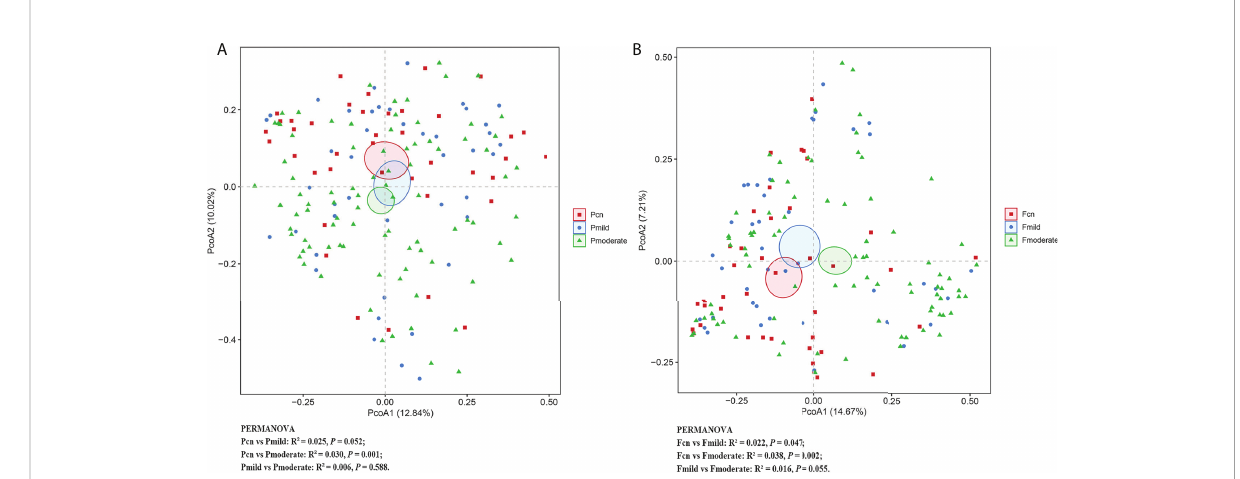
FIGURE 2 The b -diversity analysis of the subgingival plaque (A) and fecal (B) microbiota among the three groups. PCoA based on the Bray-Curtis of b -diversity analysis. PERMANOVA tests if the centroids, similar to means, of each group are signi fi cantly different from each other. R² statistic showing the community variation between the compared groups with signi fi cant p -values. Pcn, subgingival plaque of normal cognition controls; Fcn, feces of normal cognition controls; Pmild, subgingival plaque of mild AD; Fmild, feces of mild AD; Pmoderate, subgingival plaque of moderate AD; Fmoderate, feces of moderate AD; PCoA, principal coordinate